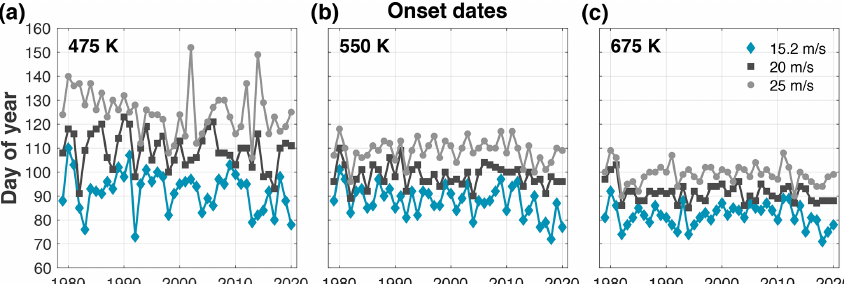
Figure 9. Interannual evolution of Antarctic polar vortex onset dates over the period 1979–2020. Panels from (a) to (c) show onset dates at 475, 550, and 675K. Light gray, dark gray, and blue curves represent onset dates for the 15.2, 20, and 25ms − 1 wind threshold values, respectively (see text).